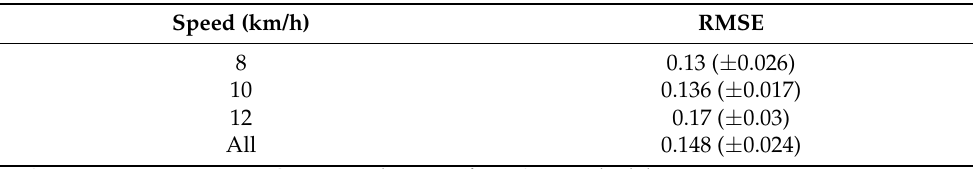
Table 1. RMSE ( ± SD) between measured and predicted GRFs.